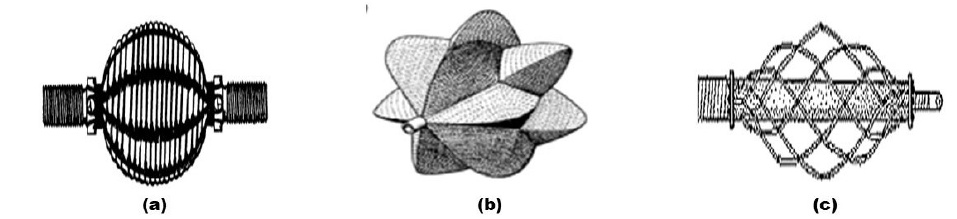
Figure 6. Netted muscle: ( a ) Yarlott muscle [18]; ( b ) ROMAC [20]; ( c ) Kukolj muscle